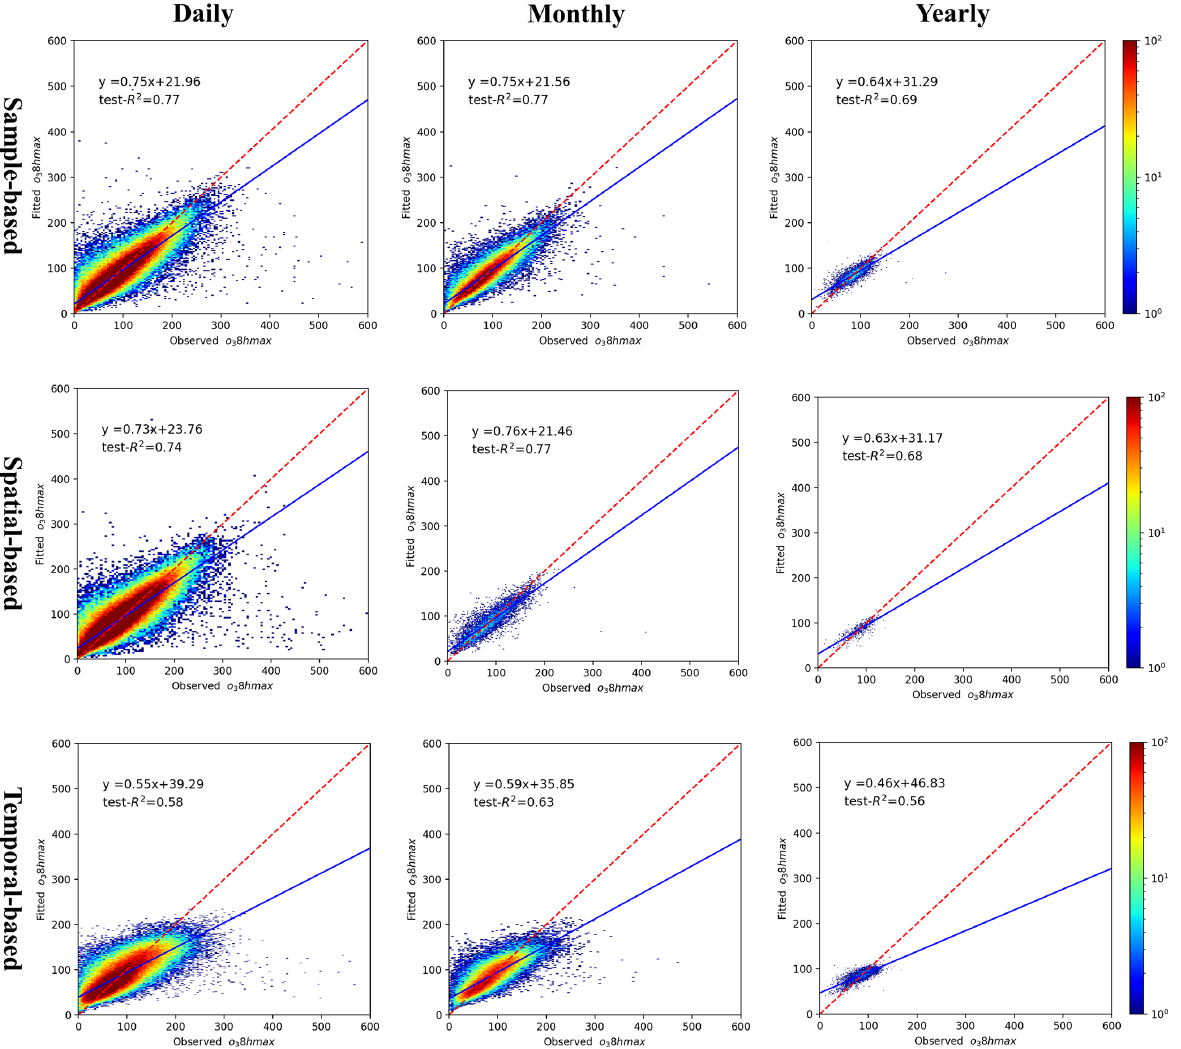
Figure 4. The density plot of O 3 -8hmax model. From left to right are the different temporal scales: daily, monthly and yearly; from top to bottom are the different validation methods: sample-based, spatial-based and